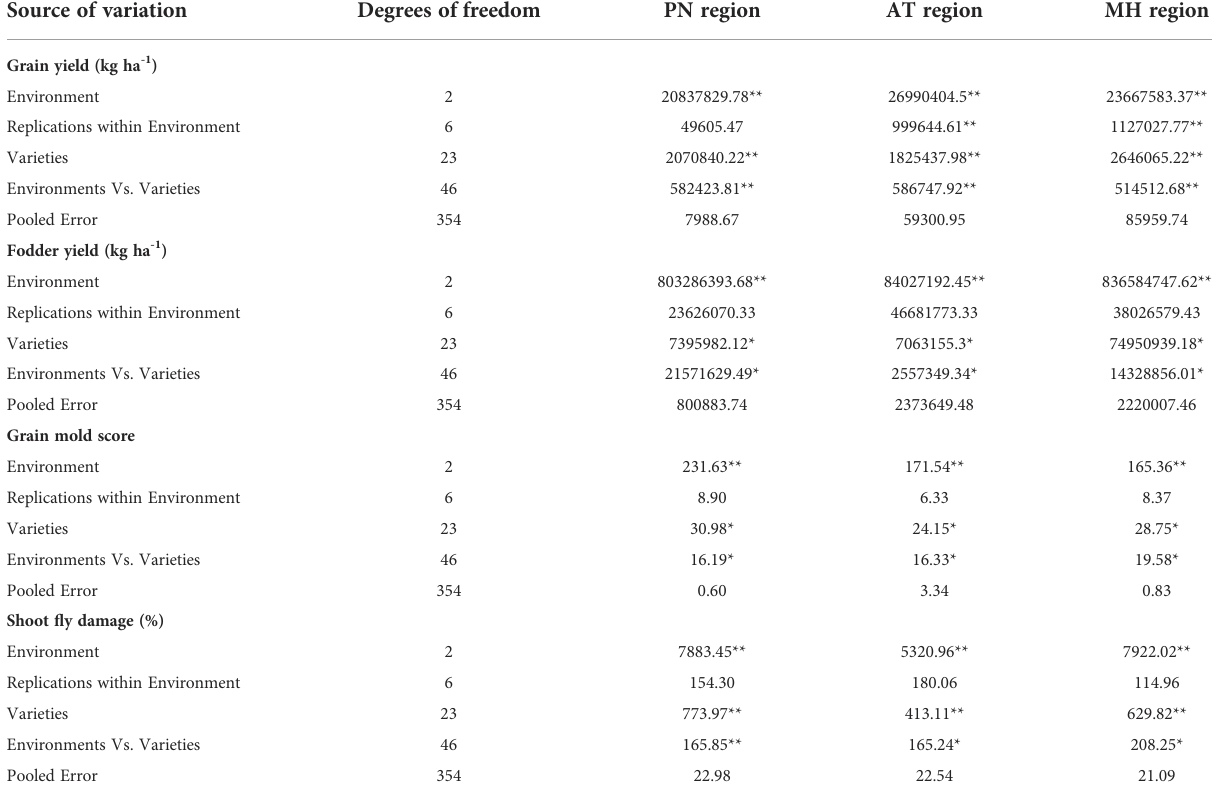
TABLE 3 Mean squares of grain yield, fodder yield, grain mold score and shoot fl y damage (%) of sorghum varieties developed during 1990-2020 across three environments during 2019-2020. Source of